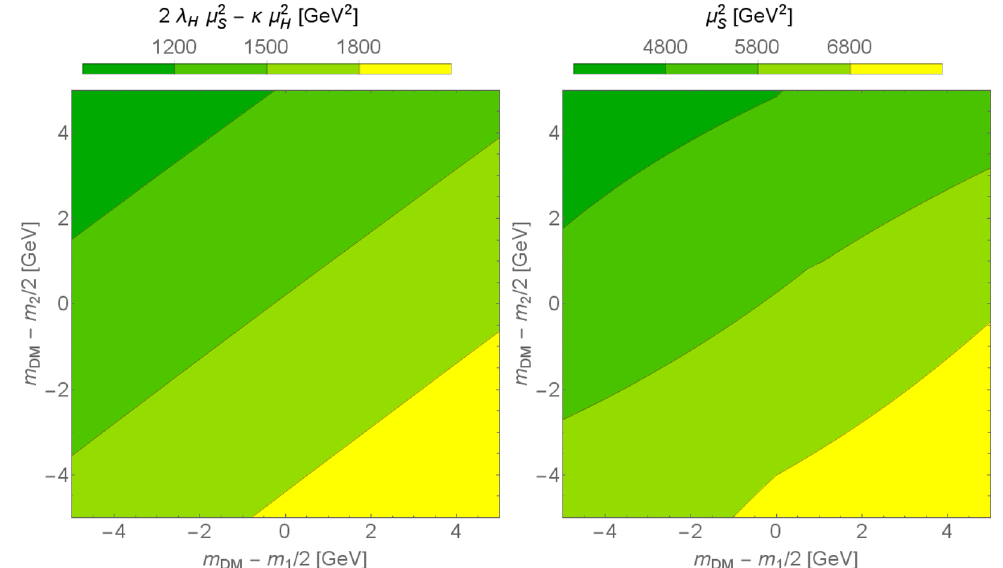
Figure 5 . Numerical test of the conditions (5.49) (left pannel) and (5.50) (right pannel) for globalness of the minimum of the scalar potential in the pGDM model. If the plotted values are positive, the conditions are satis(cid:12)ed. Value of sin (cid:11) has been assumed to be 0 : 3. Value of v S has been calculated from eq. (5.6).